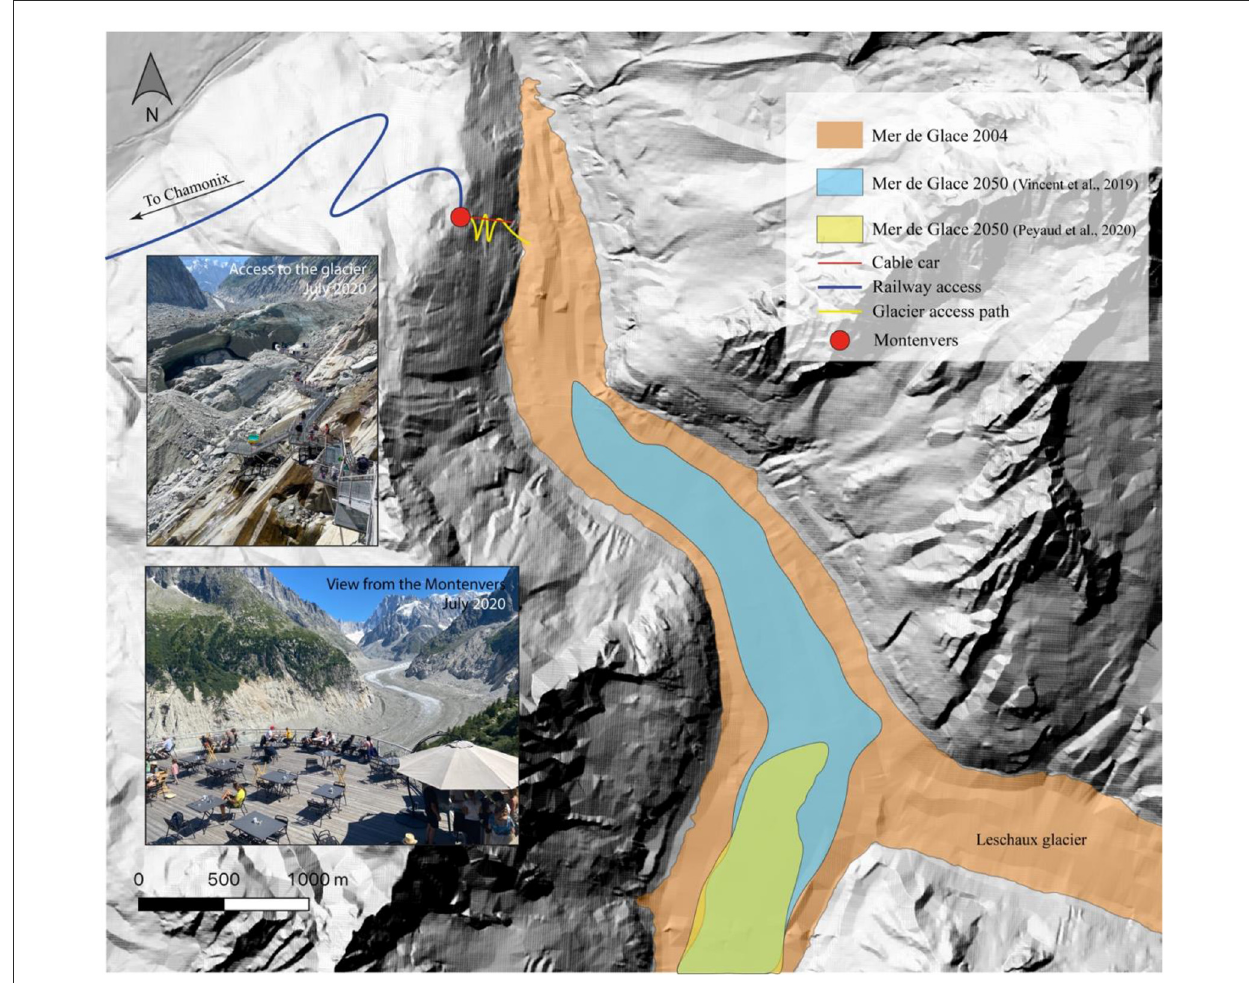
FIGURE2 The evolving state of the Montenvers Mer de Glace. The glacier extension from 2004 is based on Vincent et al. (2007), the 2050 extension represented by the color blue is based on Vincent et al. (2019), and the yellow-colored extension is based on Peyaud et al. (2020). Pictures were taken by the